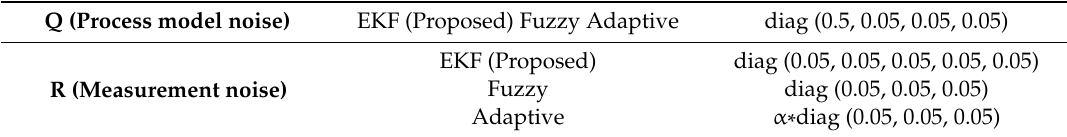
Table 1. Noise covariances of the proposed algorithm.